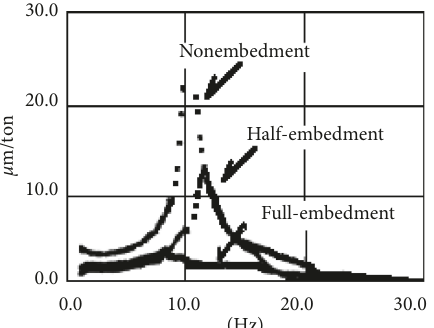
Figure 18: Comparison of displacement resonance at foundation bottom